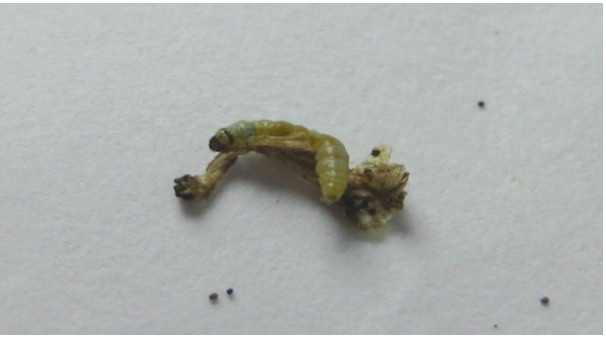
Fig.(1): Infected larva after Trichoderma viride treatment.